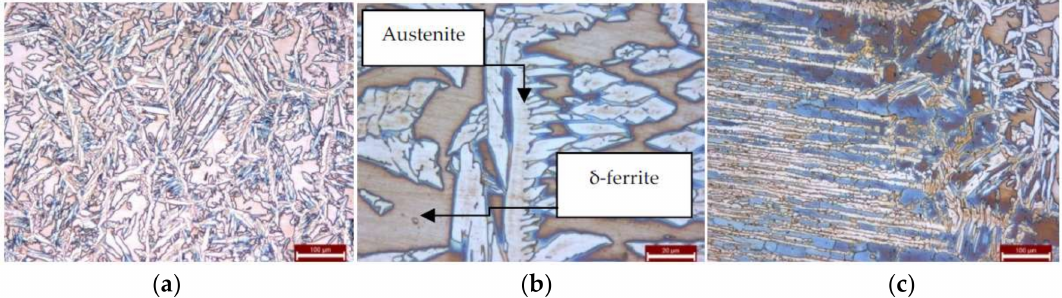
Figure 5. Micrographs of weldments by Ar + 1% N 2 shielding gas ( a ) weld metal 100 × ( b ) weld metal 500 × ( c ) HAZ 100 ×